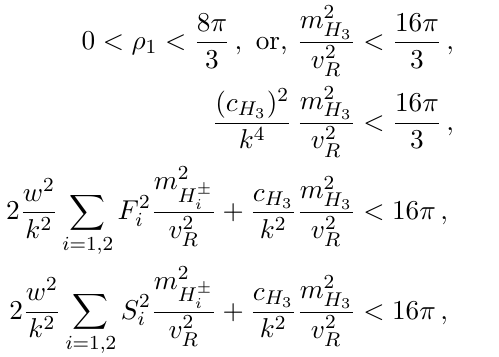
JHEP03(2023)168